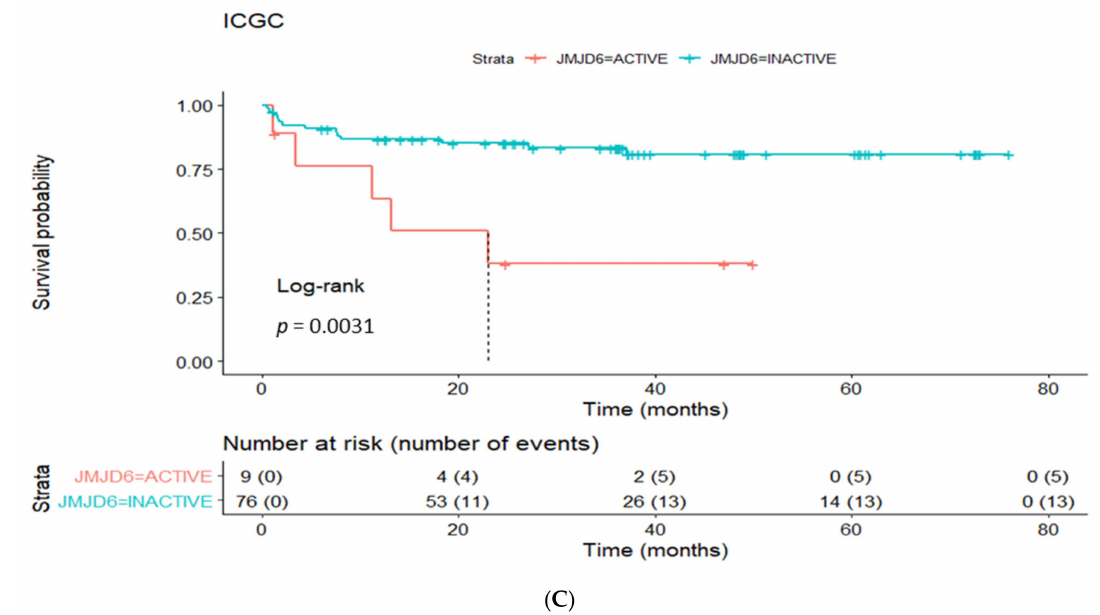
Figure 3. Disease free survival analysis of the JMJD6 regulon signature in clinical prostatectomy patient cohorts. The survival probability curves for patients in the UTA ( A ), EMC ( B ) and IGCG ( C ) cohorts were prepared with patients stratified according to the presence or absence of the enriched JMJD6 regulon in red and turquoise,